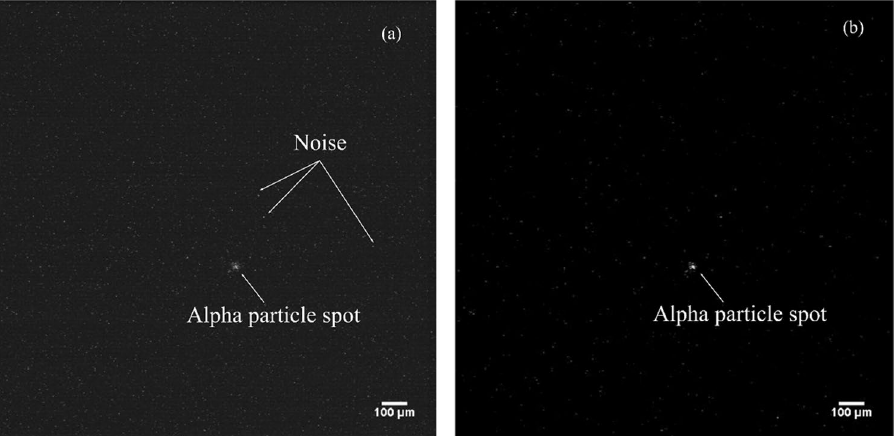
Figure 14. Example of an alpha particle spot: ( a ) before and ( b ) after the image processing. Noise signals are observed randomly distributed in the